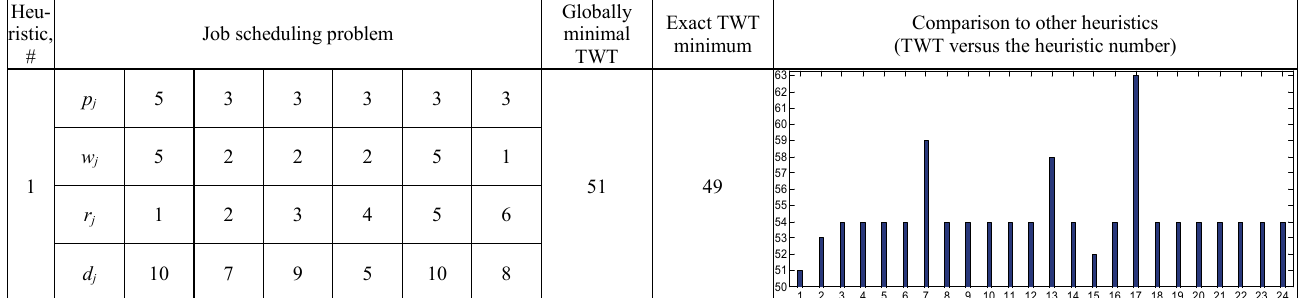
T HE E XAMPLES OF J OB S CHEDULING P ROBLEMS WITH THE G LOBALLY M INIMAL TWT